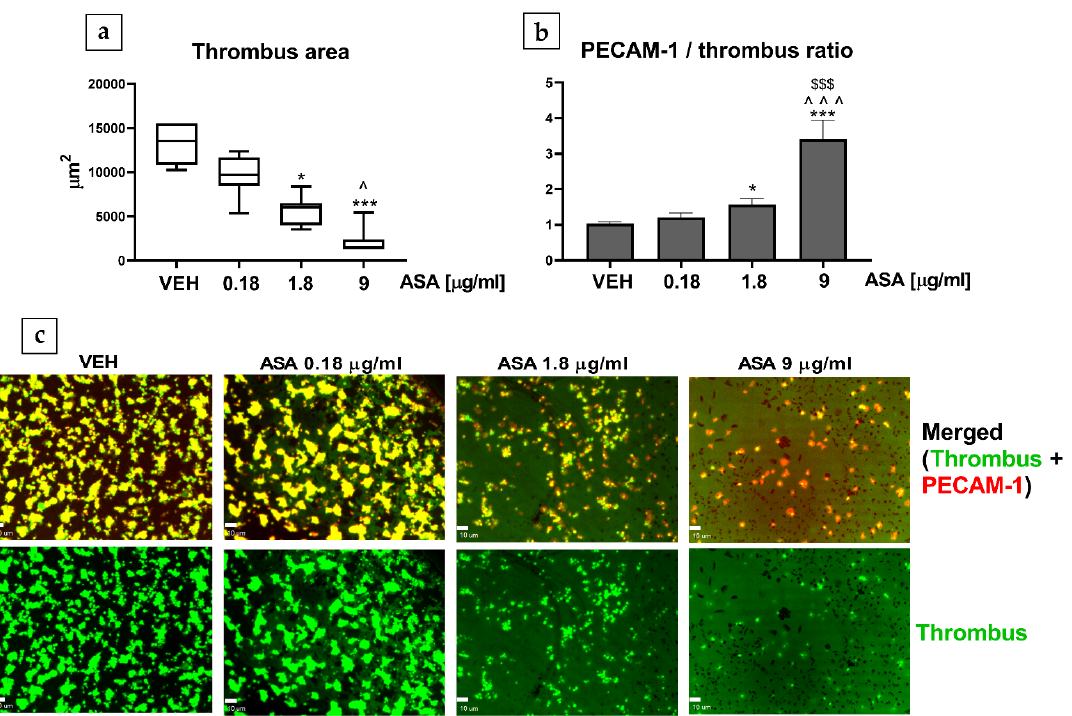
Figure 4. Effect of ASA (in vitro) on ( a ) thrombus area and ( b ) PECAM-1/thrombus ratio in the experiment with human blood. ( c ) Original, representative confocal microscopy images of merged channels (green, thrombus; red, PECAM-1) and thrombus (green) (bar = 10 μ m; * p < 0.05, *** p < 0.001 vs. VEH; ^ p < 0.05, ^^^ p < 0.001 vs. ASA 0.18 μ g/mL; $$$ p < 0.001 vs. ASA 1.8 μ g/mL; n = 7). Data are shown as mean ± SEM and as median (interquartile range).